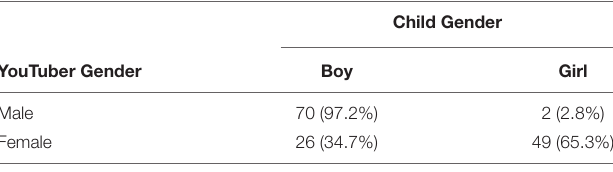
TABLE 1 | Results of chi-square test and descriptive statistics for gender congruency between YouTuber and child.